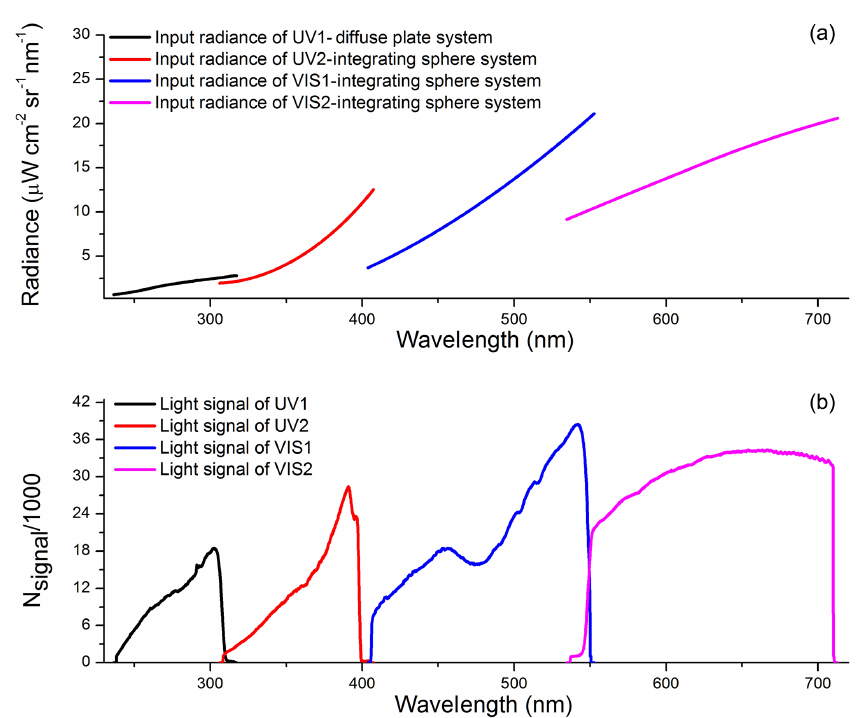
Figure 9. Panel (a) presents one radiance level of the diffuser plate and integrating sphere system. Panel (b) presents the EMI response to the radiance at integration times 2s (UV1), 1s ( UV2, VIS1, VIS2), and at gain step 0. The dark signal is subtracted from the